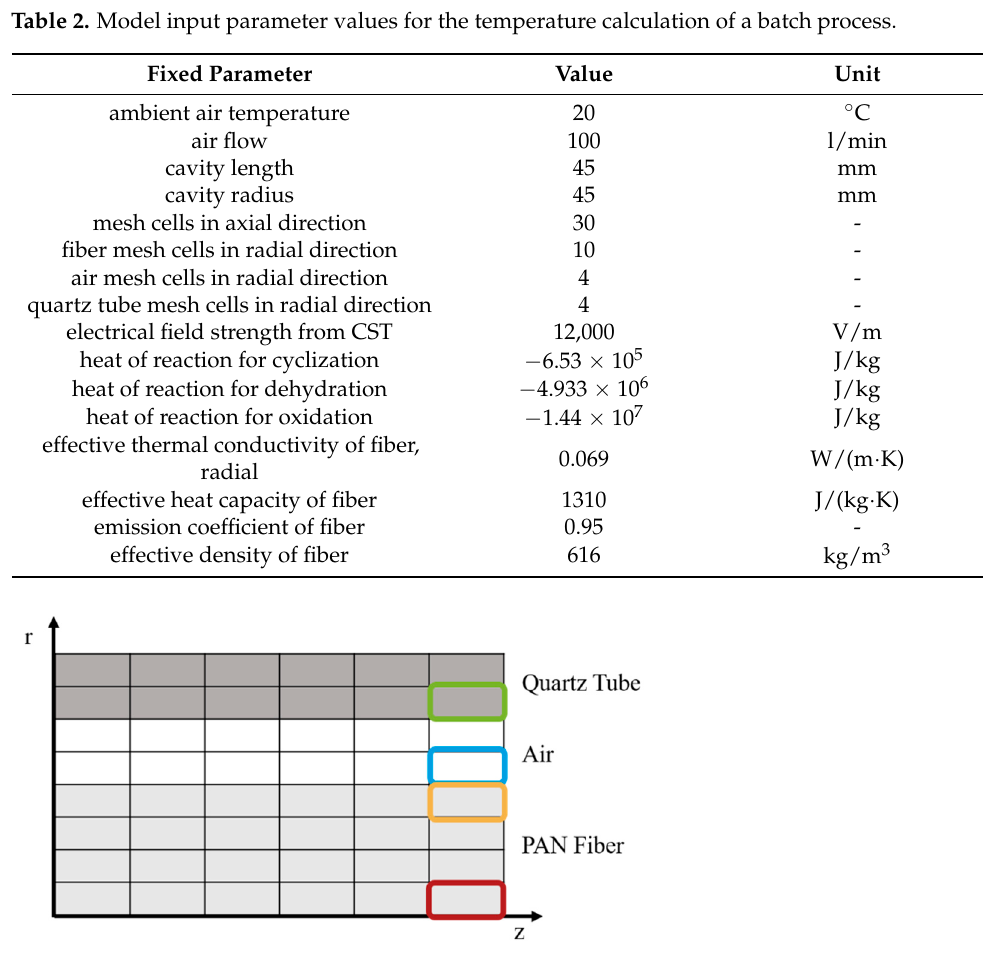
Figure 13. Schematic mesh with colored mesh cells that are evaluated over time in the next figures.